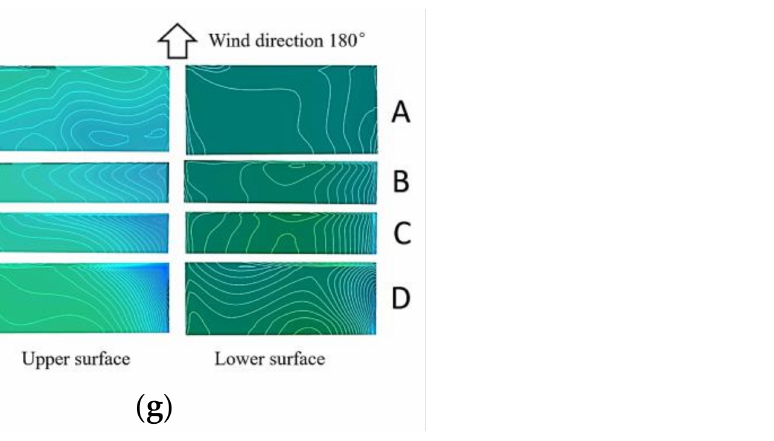
Figure 5. Distribution of wind pressure coefficients on each platform surface at different wind directions. ( a ) Case 1. θ = 0 ◦ ; ( b ) Case 2. θ = 30 ◦ ; ( c ) Case 3. θ = 60 ◦ ; ( d ) Case 4. θ = 90 ◦ ; ( e ) Case 5. θ = 120 ◦ ; ( f ) Case 6. θ = 150 ◦ ; ( g ) Case 7. θ = 180 ◦ .